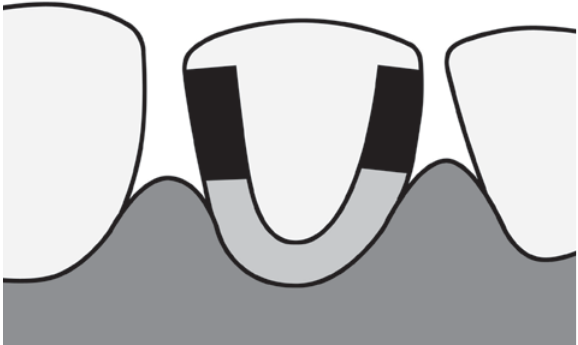
Figure 1- The stain sites of an anterior tooth: Body (White); Gingival (Grey); Mesial and Distal